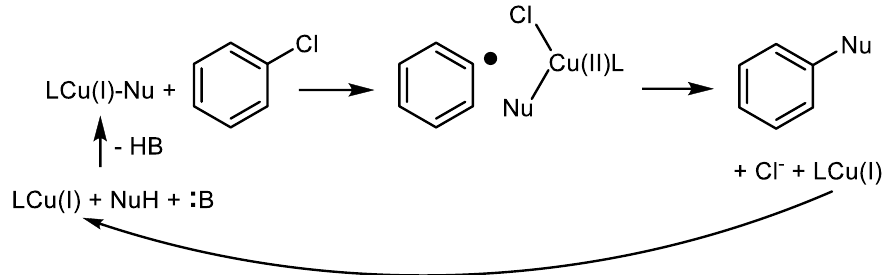
Figure 1. Structures of ligands applicable for converting aryl halides to the corresponding anilines [35 – 37,44 –